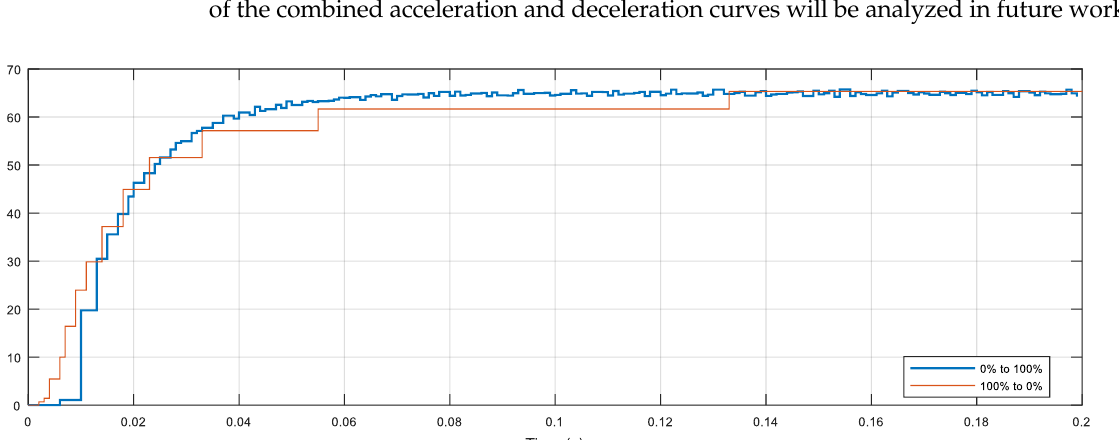
Figure 10. Motor step response for different PWM cycles.